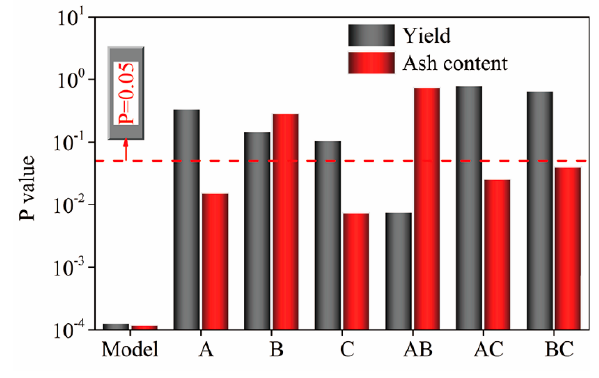
Figure A2. Significance analysis of parameters on the response variables.